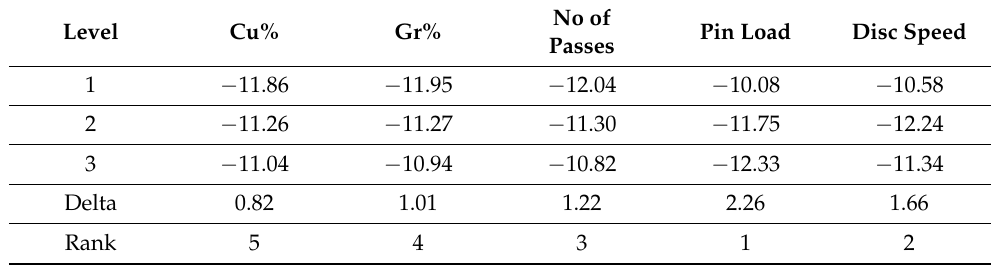
Table 6. Response table for S/N ratios for wear rate of composites processed by Tool A. Smaller is better. Level Cu% Gr%